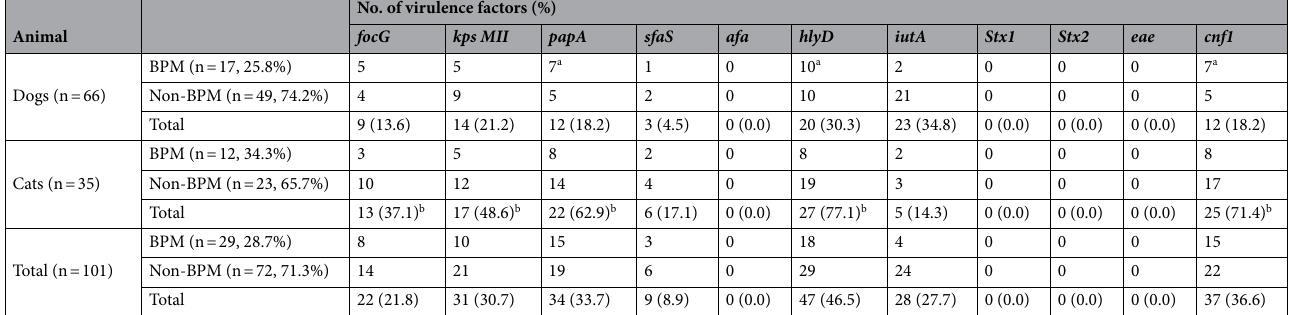
Table 2. Prevalence of virulence factors in Escherichia coli isolates from the lungs of dogs and cats. BPM bacterial pneumonia-induced mortality. a Significant difference ( P < 0.05) between bacterial pneumonia- induced mortality and mortality due to other causes in dogs. b Significant differences ( P < 0.05) in the prevalence of focG , kps MII , papA , hlyD and cnf1 between dogs and